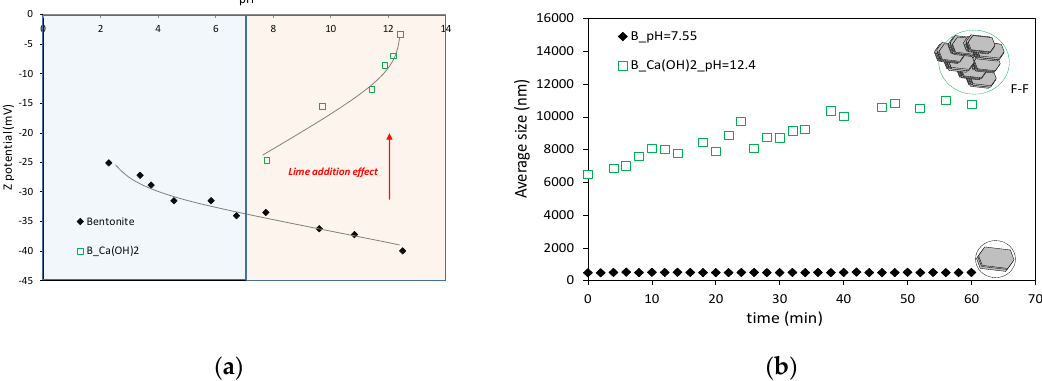
Figure 6. ( a ) Effects of pH and Ca(OH) 2 on the surface charge of bentonite suspensions; ( b ) Evolution of the average floc size of bentonite suspensions.